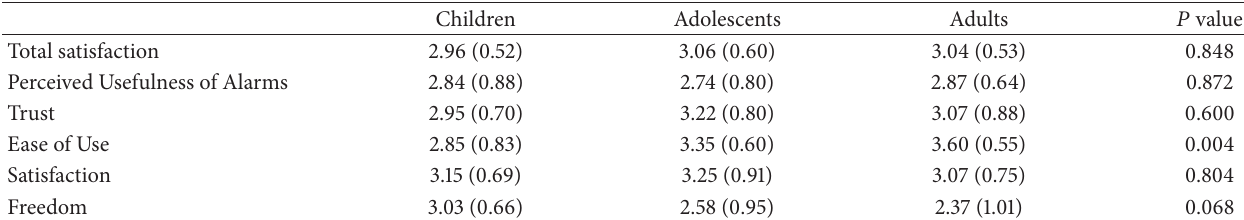
Table 4: Satisfaction scores after 4 nights with the MD-Logic artificial pancreas in home